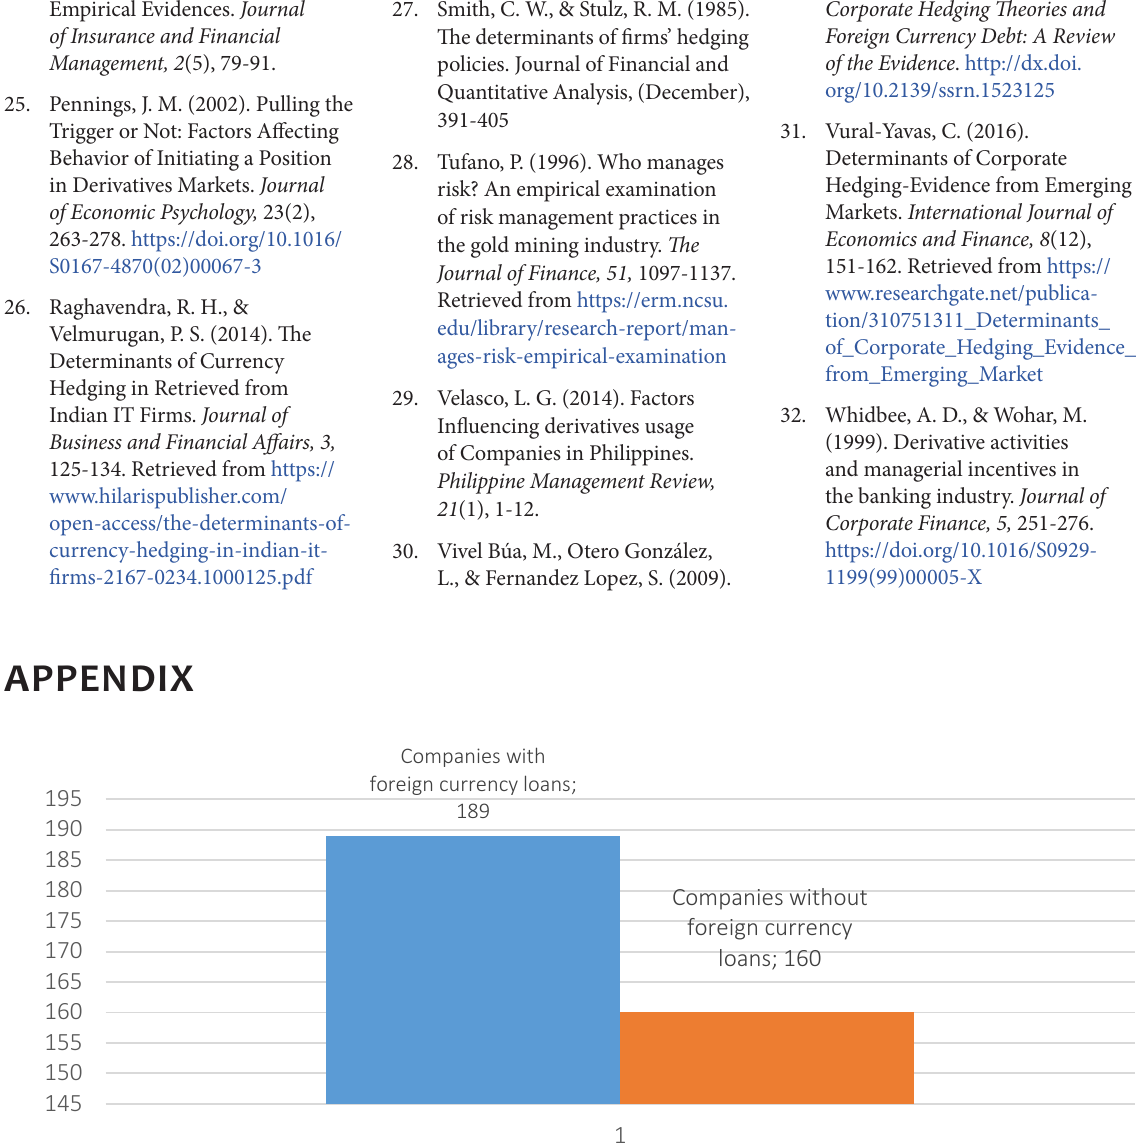
Figure 1. No. of companies with/without foreign currency loans